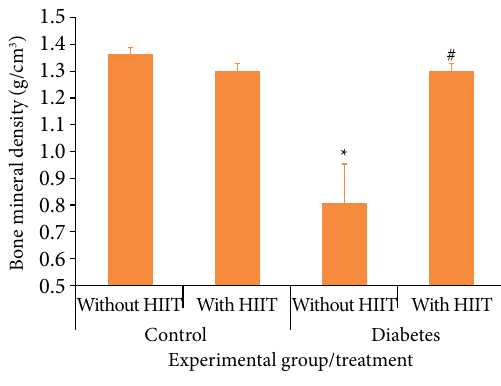
Figure 2 - Bone mineral density in each experimental group and applied treatment. Each column represents the mean and the bar the standard error of the mean.